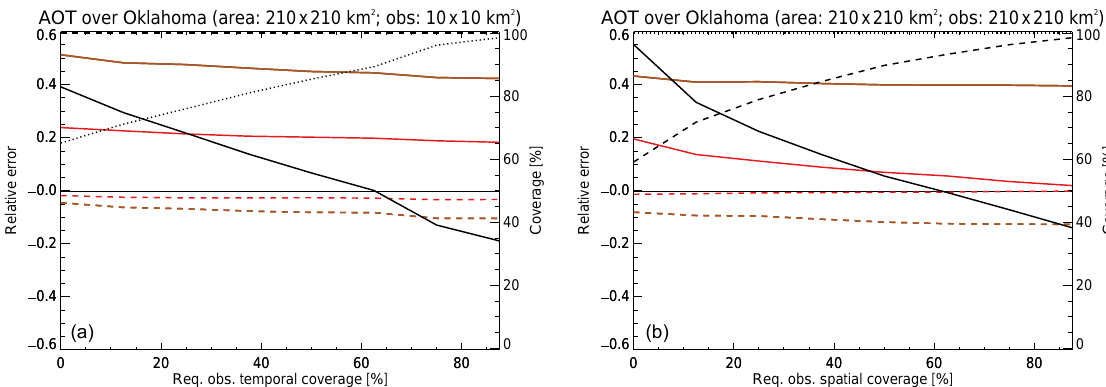
Figure 20. Daily representation errors for remote sensing instruments as a function of required coverage. Results shown for no collocation (brown) and area data collocated to the hour (red). Panel (a) is for a ground site, (b) for an imager on a polar-orbiting satellite with a 1-day repeat cycle. Further explanation in Sect. 3.2. Table 5. Optimal averaging periods for ground-site measurements used to represent a 210 × 210km 2 area (hourly). The font types indicate an increase of representation RMSD representation by less than 5% (italic font), less than 10% (bold font) or less than 20% (underlined) when using the recommended period of 6h